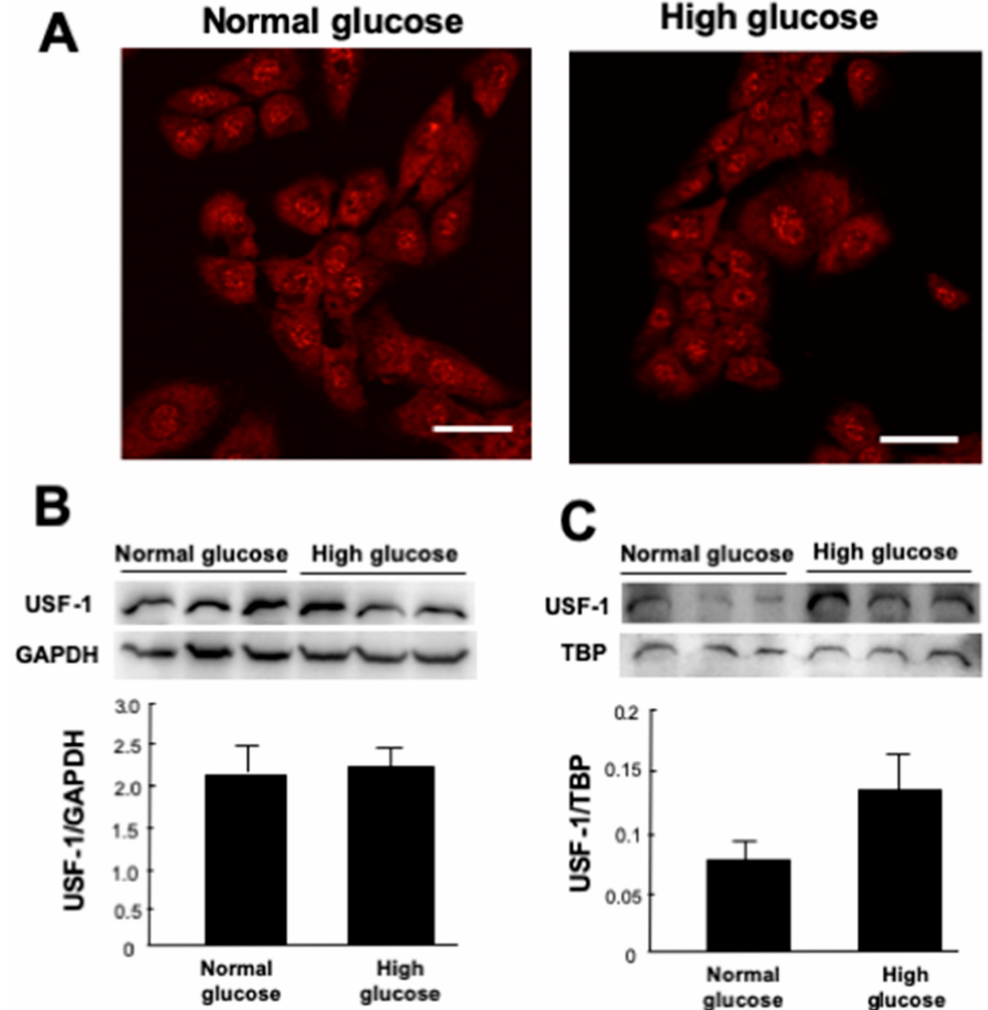
Figure 2. Cellular localization of upstream stimulatory factor (USF1) protein in mesangial cells (MCs) with high-glucose stimulation. ( A ) Immunofluorescence staining of USF1 in MCs. Cells were cultured in normal glucose (5.6 mM) or high glucose (25 mM) in DMEM with 0.5% FBS for 20 h. Then, cells were incubated with rabbit anti-USF1 antibody. Scale bar = 50 µ m. Expression of USF1 protein in ( B ) the cytoplasm and ( C ) nucleus of MCs with normal glucose or high-glucose stimulation by Western blot analysis. Data are the mean ± SEM ( n = 4). GAPDH: a cytoplasm control. TBP: TATA binding protein, a nucleus